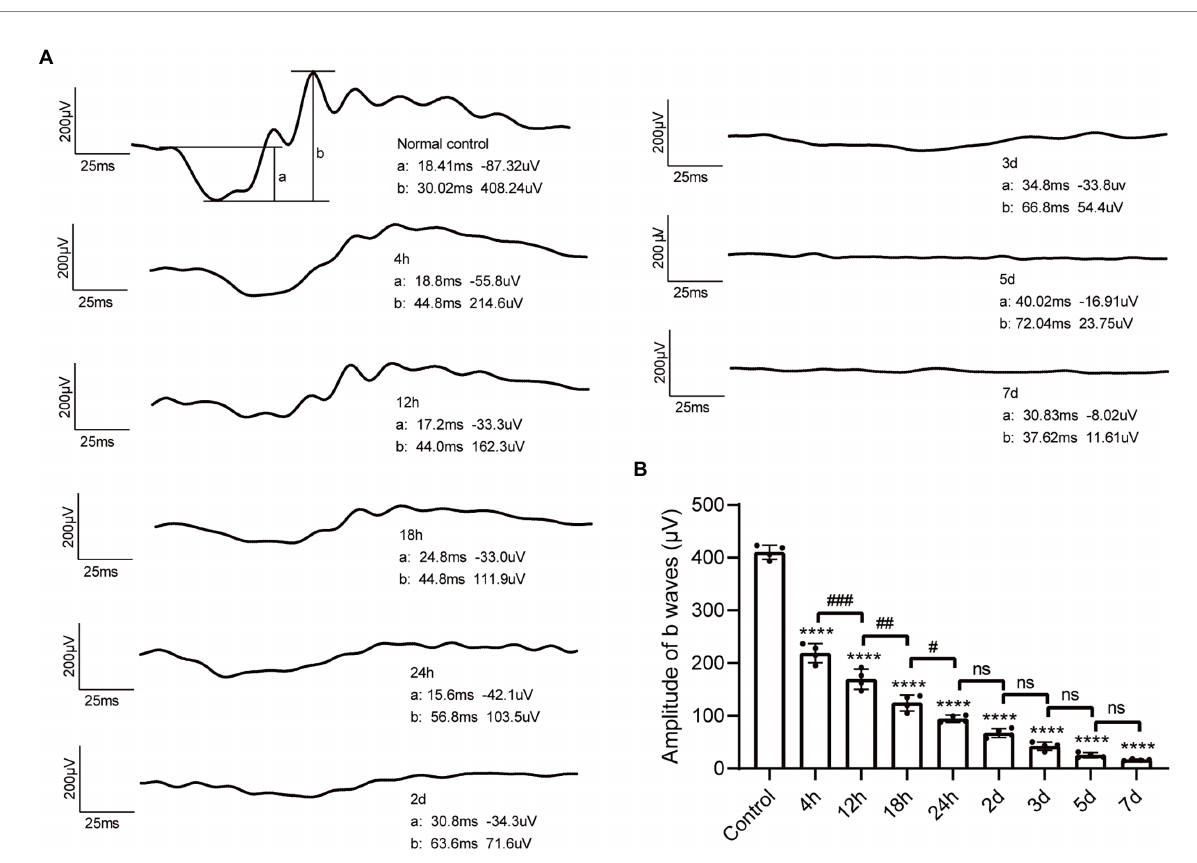
FIGURE 3 Changes of ffERG waveforms after MMS administration. (A) Representative waveform of dark-3.0 ERG recordings in control mice and MMS treated mice at different time points. (B) Quantification of b-wave amplitudes in the MMS treated mice compared to the controls. Data were expressed as mean ± SD, n = 4/group. One-way ANOVA analysis followed by Tukey’s post hoc test, **** p < 0.0001 for differences compared to controls, # p < 0.05, ## p < 0.01, ### p < 0.001 for differences compared to the previous time point